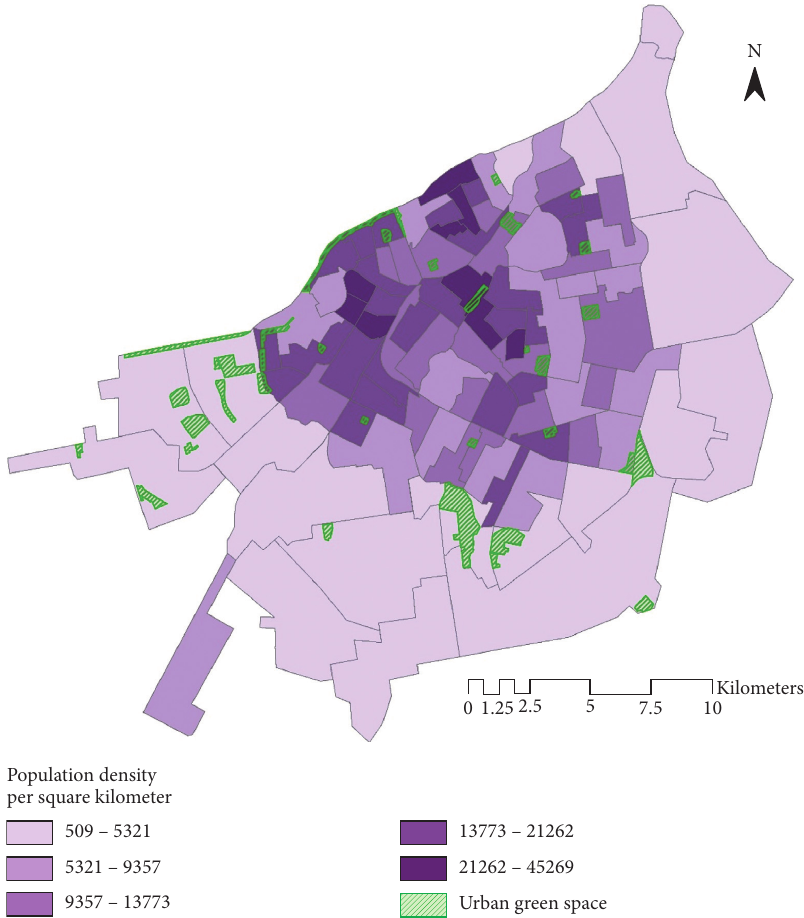
Figure 2: Population density of residential tracts and distribution of urban green